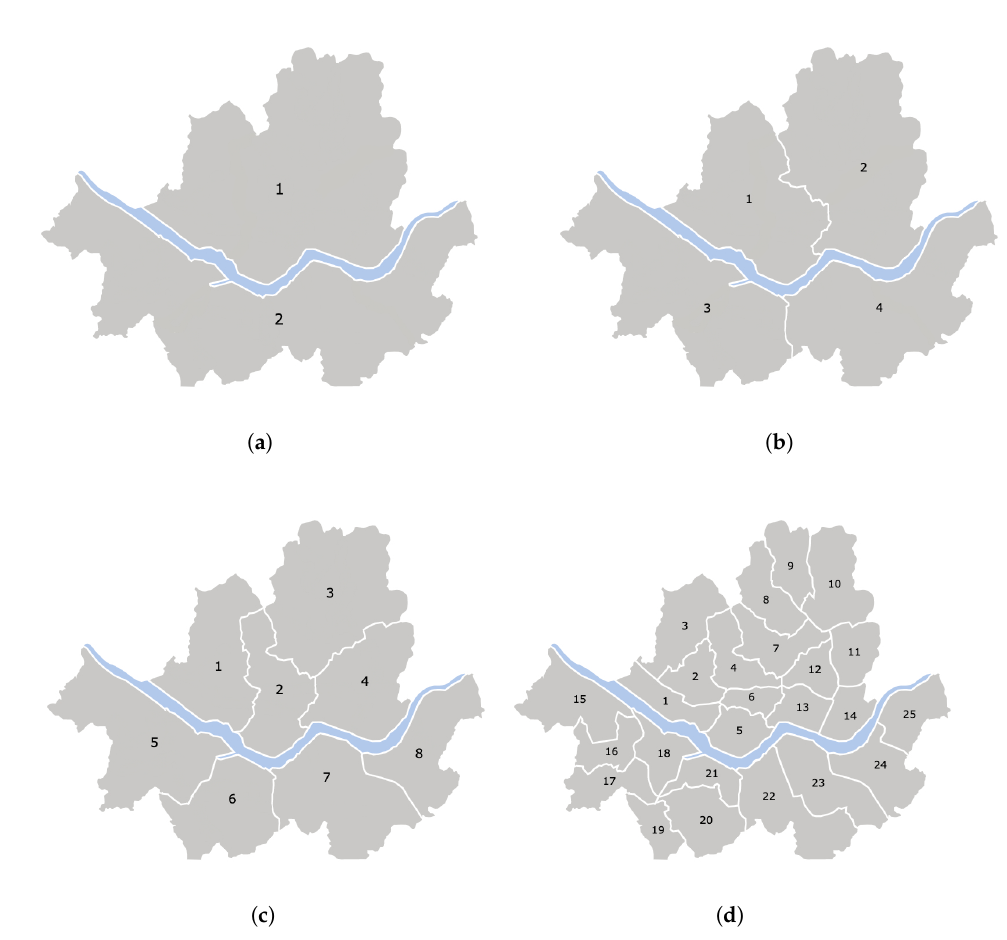
Figure 4. Seoul is divided into ( a ) 2, ( b ) 4, ( c ) 8, and ( d ) 25 zones. The matching process occurs independently within each